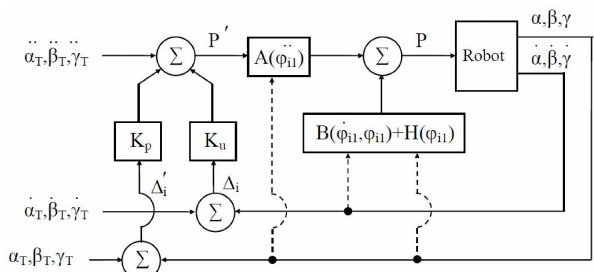
Figure 5. Control